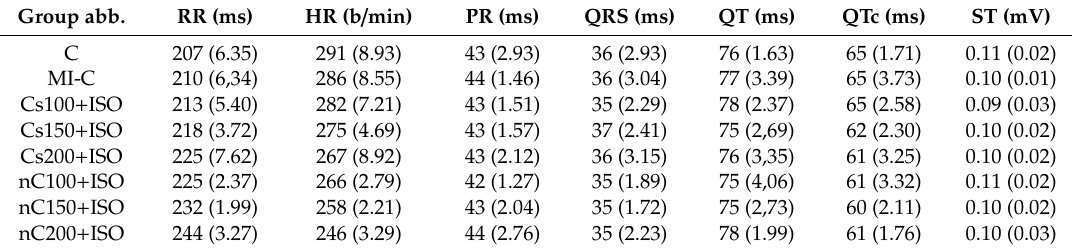
Figure 1. ECG record on day 0, at the beginning of the experiment. Table 3. ECG characteristics by group before isoproterenol (ISO) administration.